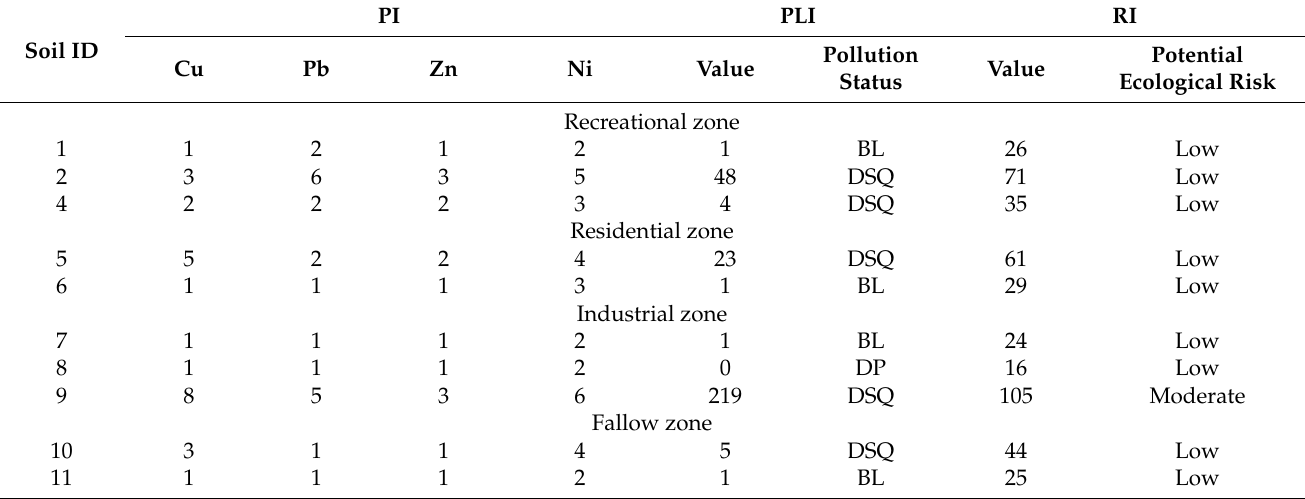
Table 6. Qualitative assessment of contamination in topsoil horizons. The soil ID corresponds to Table 1.